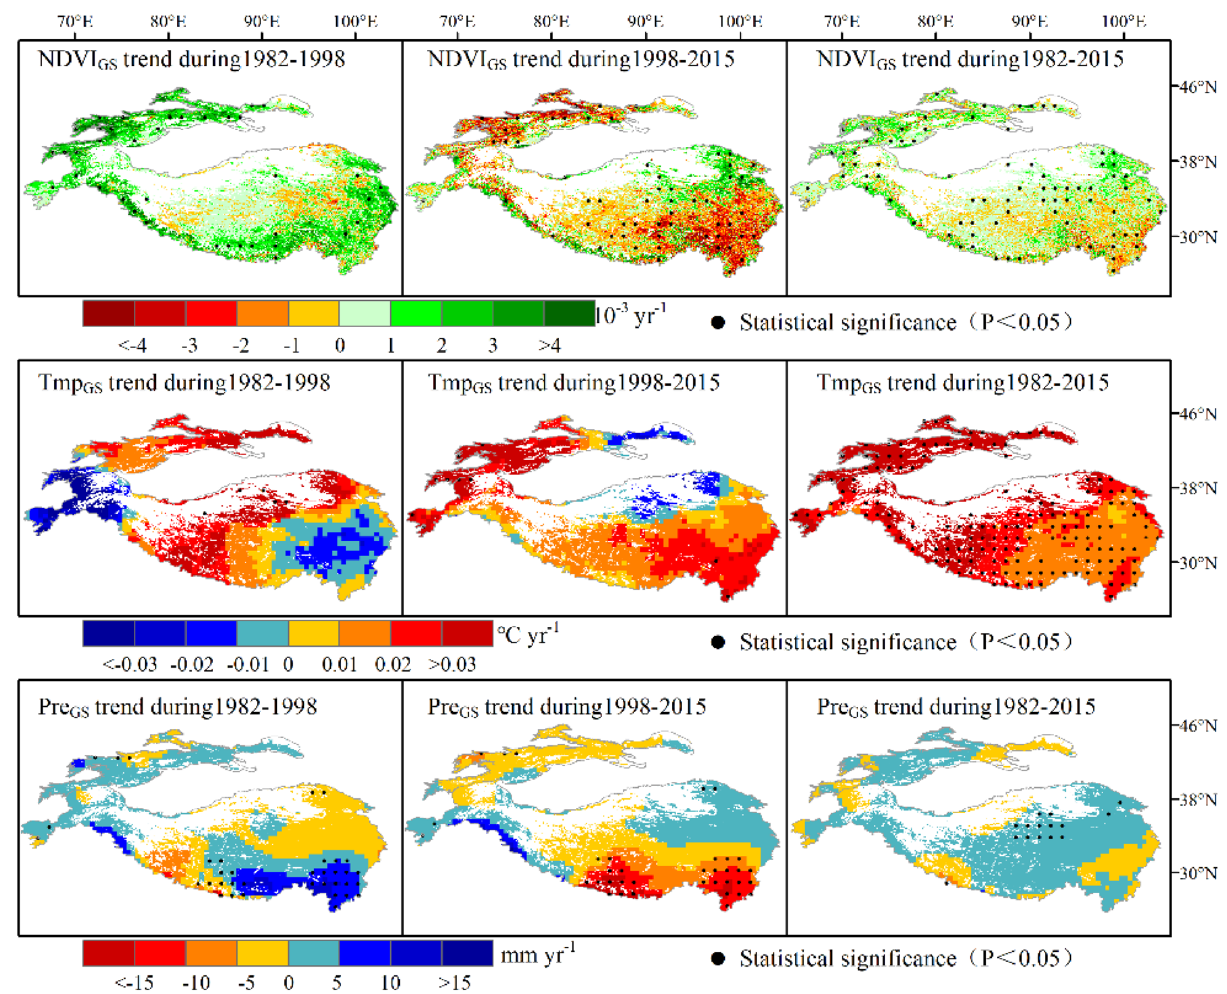
Figure 3. Spatial distribution of growing season (May–October) NDVI trends for air temperature and precipitation in HMA from 1982 to 2015. Note that regions with black dots indicate that trend values are statistically significant (p < 0.05) (Generated by ArcGIS 10.3, URL: http:// www. esri. com/ softw are/ arcgis/ arcgis- for- deskt